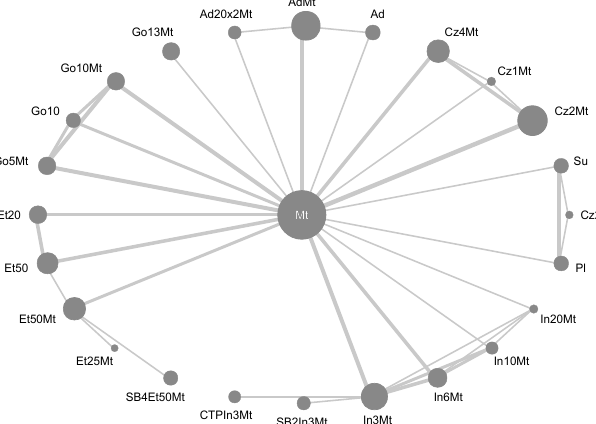
Figure 2. Network of treatments investigated in included studies. (Ad20x2Mt (adalimumab 20 mg / 1 week plus MTX); AdMt (adalimumab 40 mg / 2 weeks plus MTX); Ad